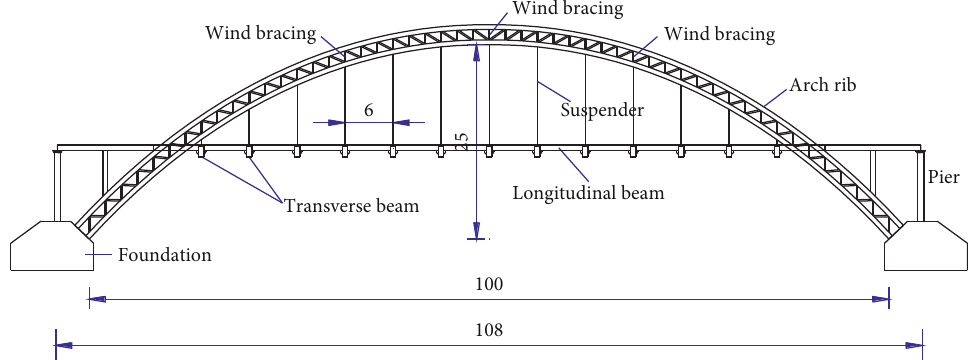
Figure 2: Elevation view of the main bridge (unit: m).